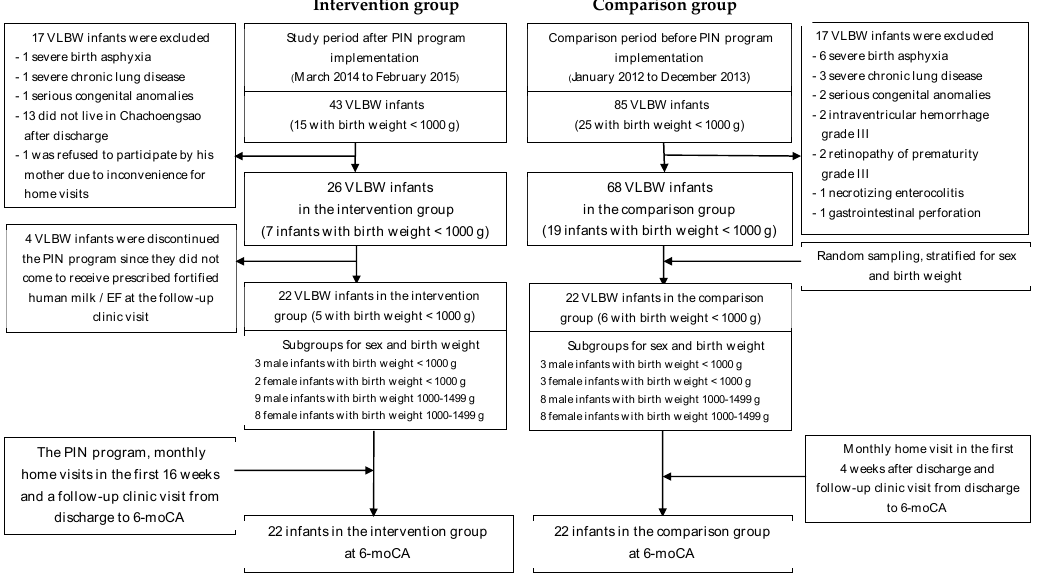
Figure 1. Recruitment process of participants. VLBW = very low birth weight, PIN = preterm infant post-discharge nutrition, EF = enriched-nutrient formula, g = gram, moCA = months corrected age.